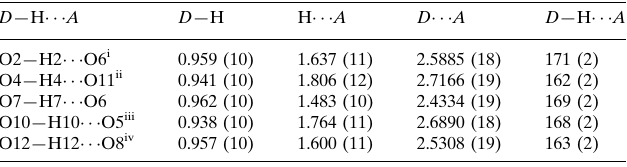
Hydrogen-bond geometry (A˚ , (cid:3)